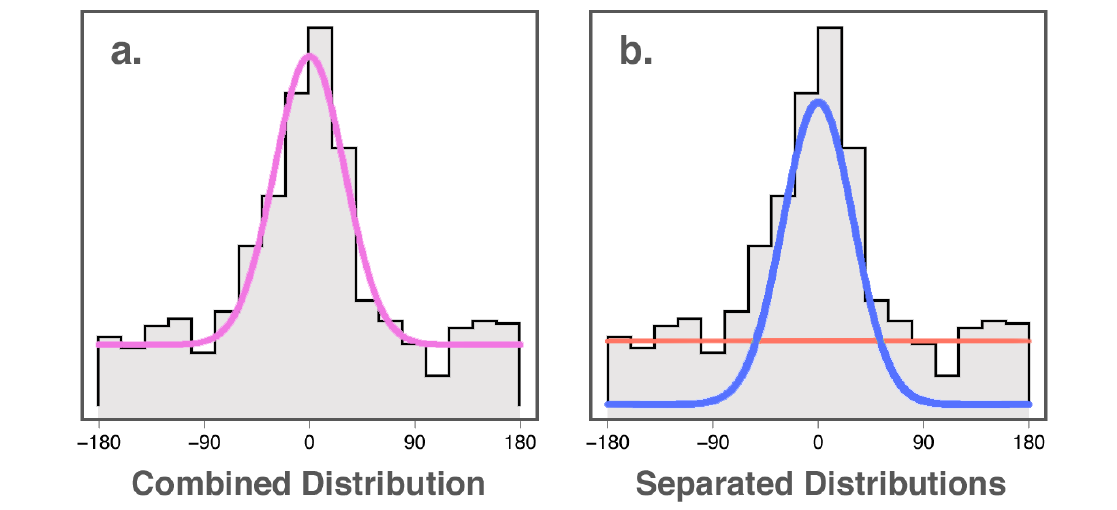
Figure 1. ( a ) combined distribution of random guesses and responses for perceived colours on a colour wheel task; ( b ) separated uniform (red line) and von Mises (blue line) distributions for the same colour wheel response data.